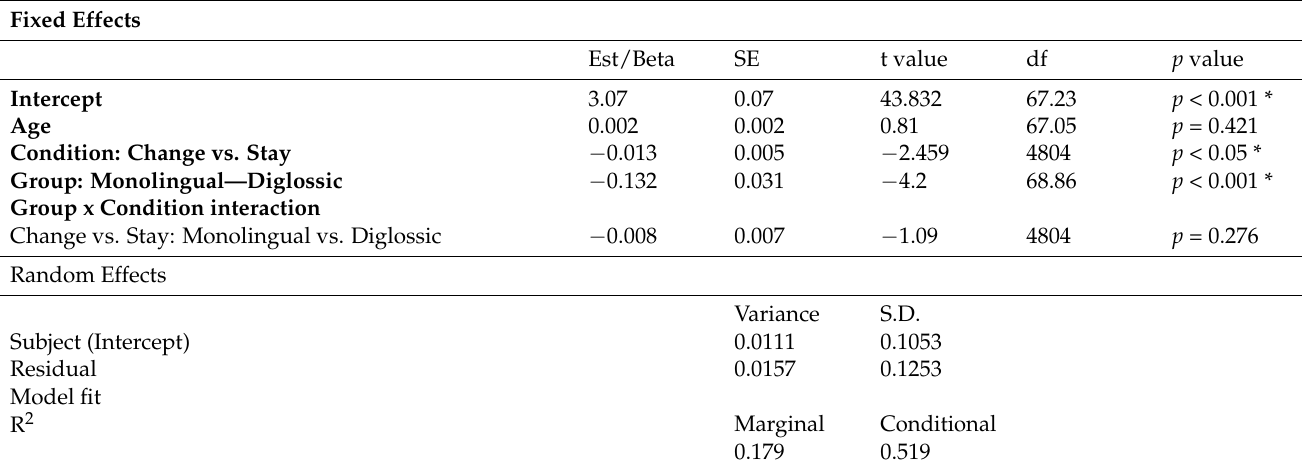
Table 6. Reaction time results for the Color-shape